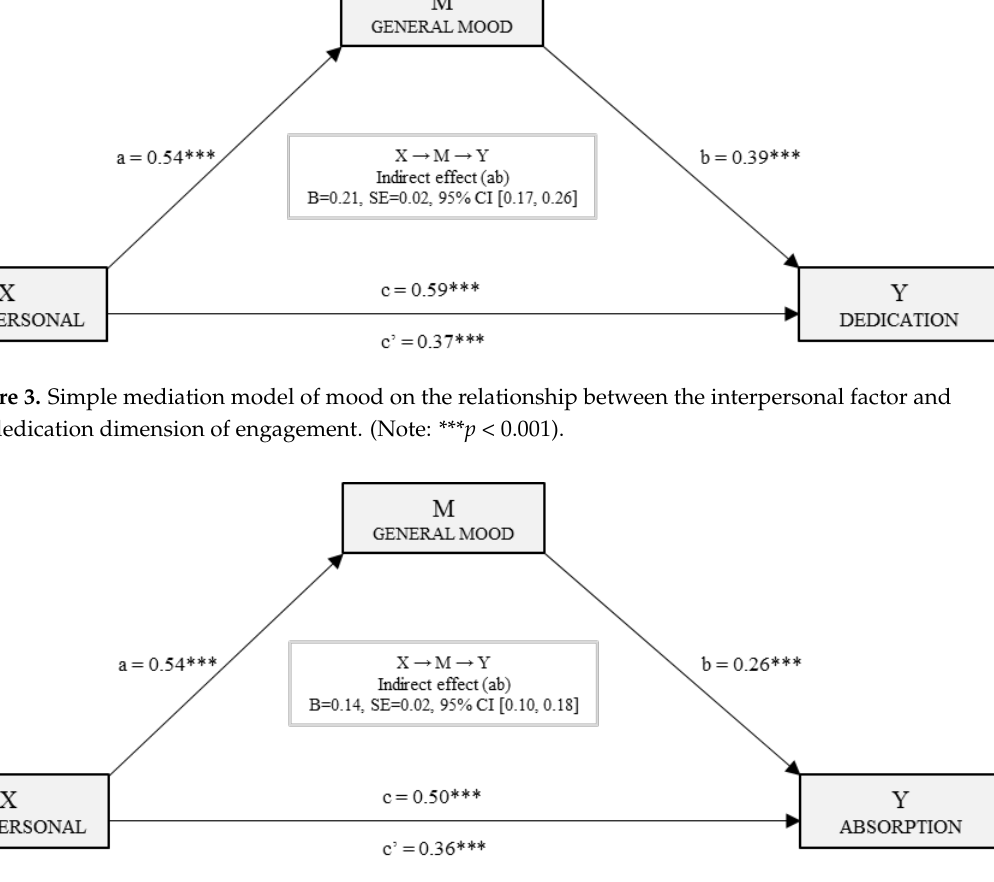
Figure 4. Simple mediation model of mood in the relationship between the interpersonal factor and the absorption dimension of engagement. (Note: *** p < 0.001)